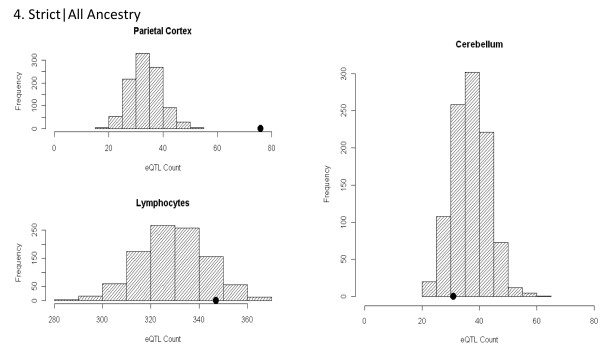
 Histograms of expression quantitative trait loci enrichment analyses for Strict|All dataset. The gray histogram distributions represent the null distribution created by 1,000 lists of randomly ascertained SNPs drawn from the 1 M array platform and conditioned on minor allele frequency. The black dot represents the actual count of SNPs annotated as eQTL present in each tissue in the Strict|All Ancestry analysis. Significant enrichment of parietal eQTL (P <0.001), but not cerebellar (P <0.872) or LCL (P <0.110) eQTL was identified in the Strict|All dataset. eQTL: expression quantitative trait loci; LCL: lymphoblastoid cell line; SNP: single nucleotide polymorphism.